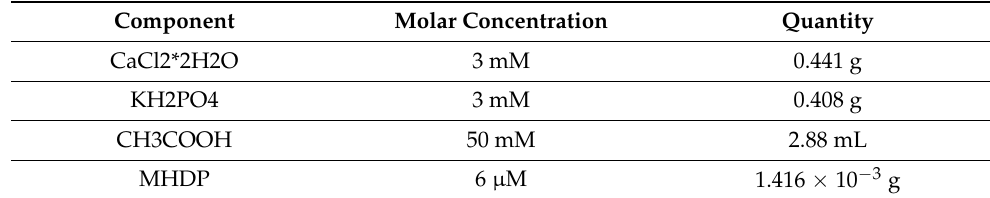
Table 1. Composition of the solution for demineralization of hard tooth tissues.